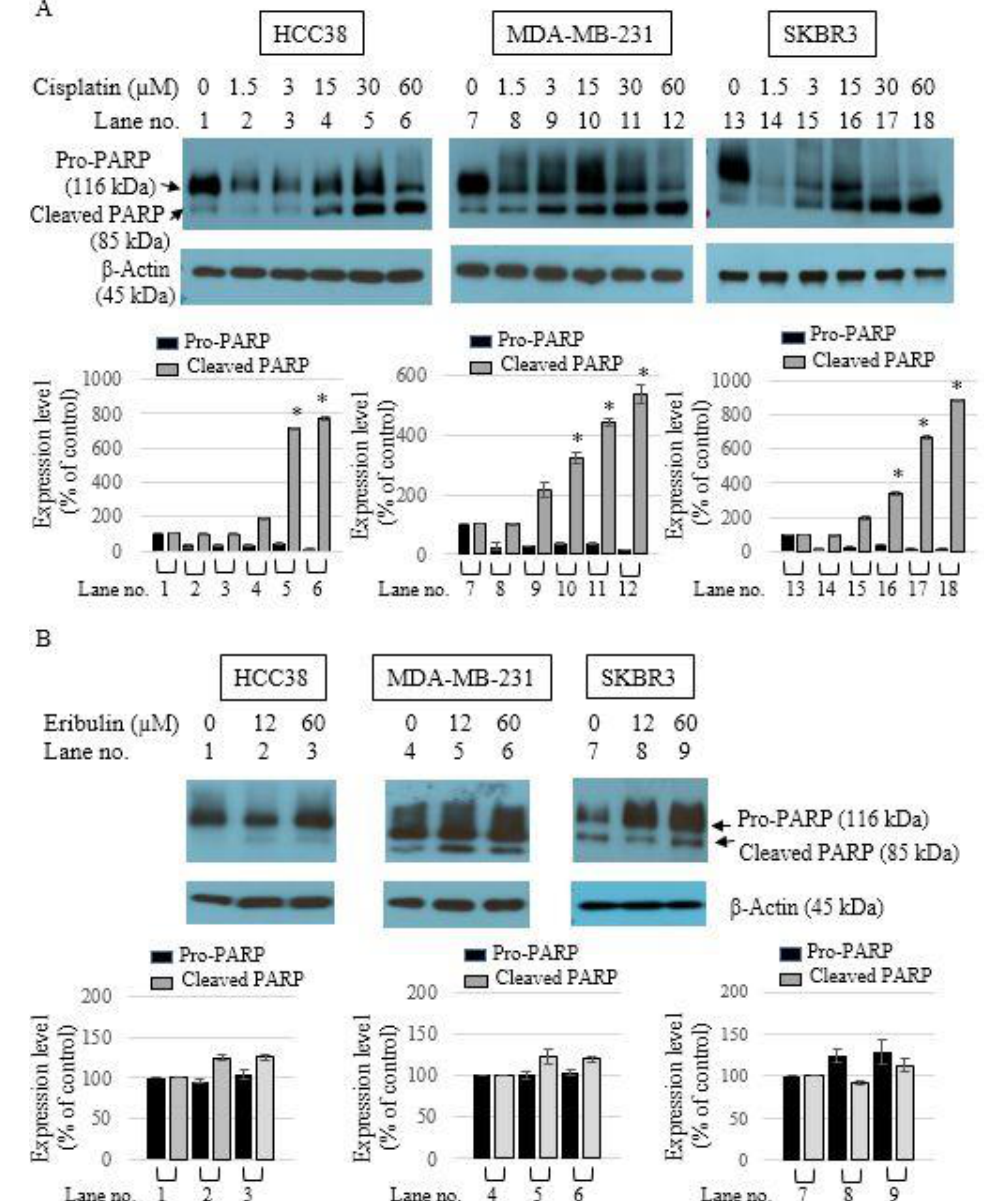
Figure 2. Apoptotic effect of cisplatin or eribulin on PARP cleavage in HCC38, MDA-MB-231, and SKBR3 breast cancer cells. Cells were treated with cisplatin (1.5, 3, 15, 30, and 60 µ M) ( A ) or eribulin (12 and 60 µ M) ( B ) for 24 h. Cleavage of the caspase substrate PARP in the presence of cisplatin or eribulin is shown. Cells were harvested after 24-h cisplatin or eribulin treatment. PARP cleavage was assessed by Western blot analysis using an anti-PARP antibody. β-Actin was used as the internal control. Data are presented as the mean ± standard deviation; * p < 0.05 vs. untreated control.